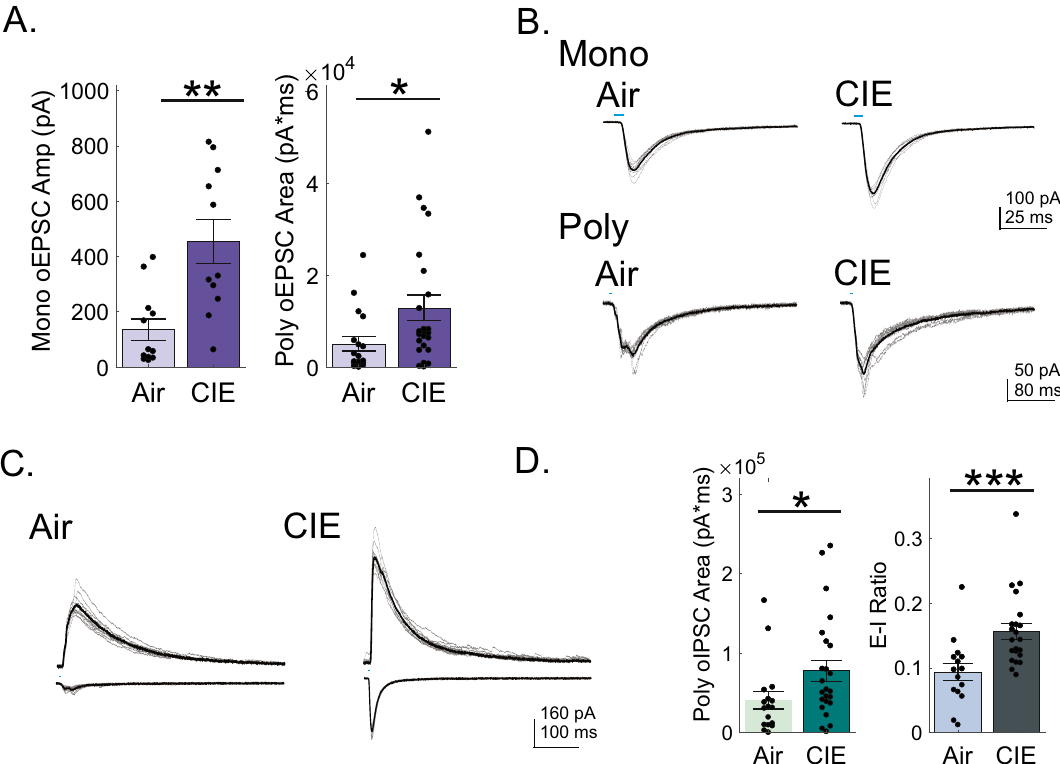
Figure 2. CIE shifts the excitatory/inhibitory balance in the BLA-vSub pathway toward a hyperexcitable state ( A ) Monosynaptic oEPSC amplitudes (left graph) and polysynaptic oEPSC areas (right graph) are increased in vSub neurons of CIE rats. ( B ) Representative monosynaptic (upper traces) and polysynaptic (lower traces) traces from a vSub neuron of Air (left column) and CIE (right column) rats. ( C ) Representative traces of oIPSCs (upper traces) and oEPSCs (lower traces) recorded from the same neuron. ( D ) Polysynaptic oIPSC areas are increased in vSub neurons of CIE rats (right panel) but this increase is smaller than the relative increase in oEPSC areas, resulting in an overall greater E/I ratio (right panel). In representative traces, individual inputs are shown by thin lines while the average response amplitude is illustrated by a thicker overlaid line. Blue bars above figures illustrate onset and duration of optical stimulation. *p < 0.05, ** p < 0.01 and ***p < 0.001 and errors are reported as ±